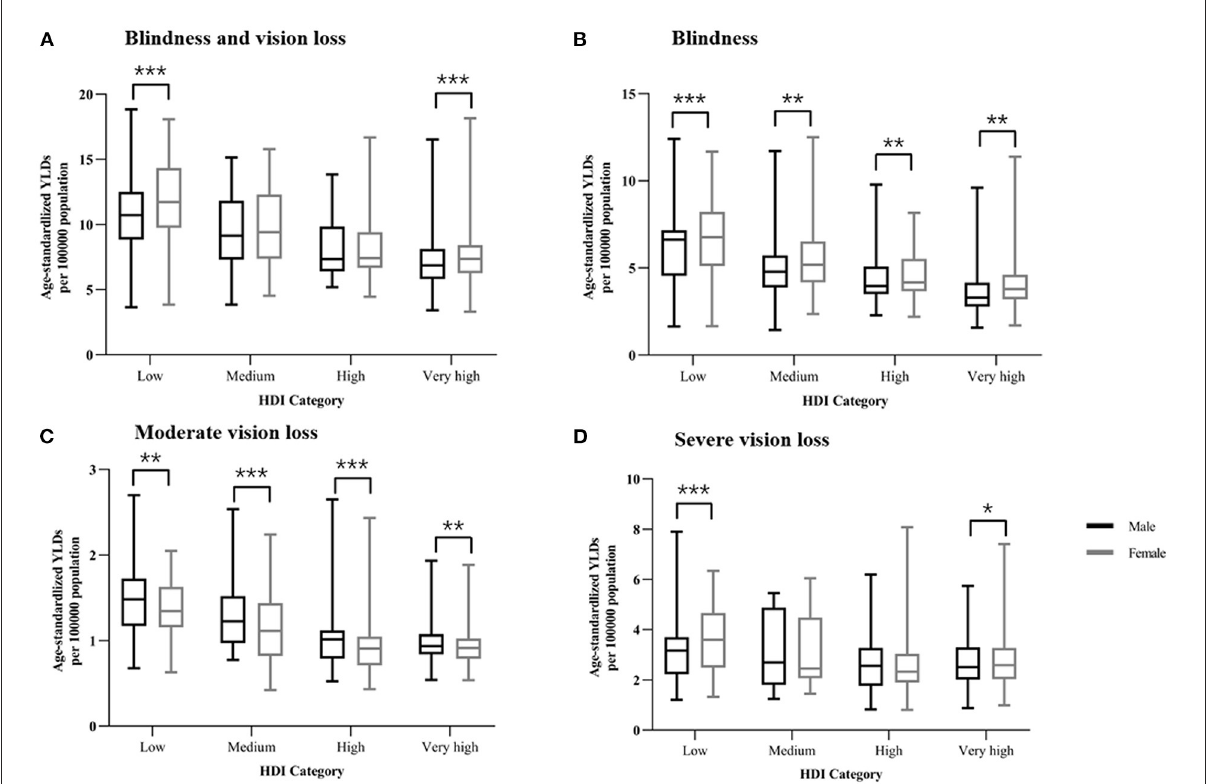
FIGURE4 Sex difference of NPB-related vision impairment burden in four socioeconomic development levels. Sex disparities in the burden of (A) NPB-related blindness and vision loss, (B) NPB-related blindness, (C) NPB-related moderate vision loss, and (D) NPB-related severe vision loss by each HDI-based country group in 2019, as measured by age-standardized YLD rates. Lines inside the boxes indicate the medians; boxes represent the 25 and 75% percentiles; and lines outside the boxes show the minimum and the maximum values. For difference between sexes, * P < 0.05, ** P < 0.01, *** P < 0.001. Wilcoxon signed ranks test. NPB, Neonatal preterm birth; YLDs, years lived with disability; HDI, Human Development